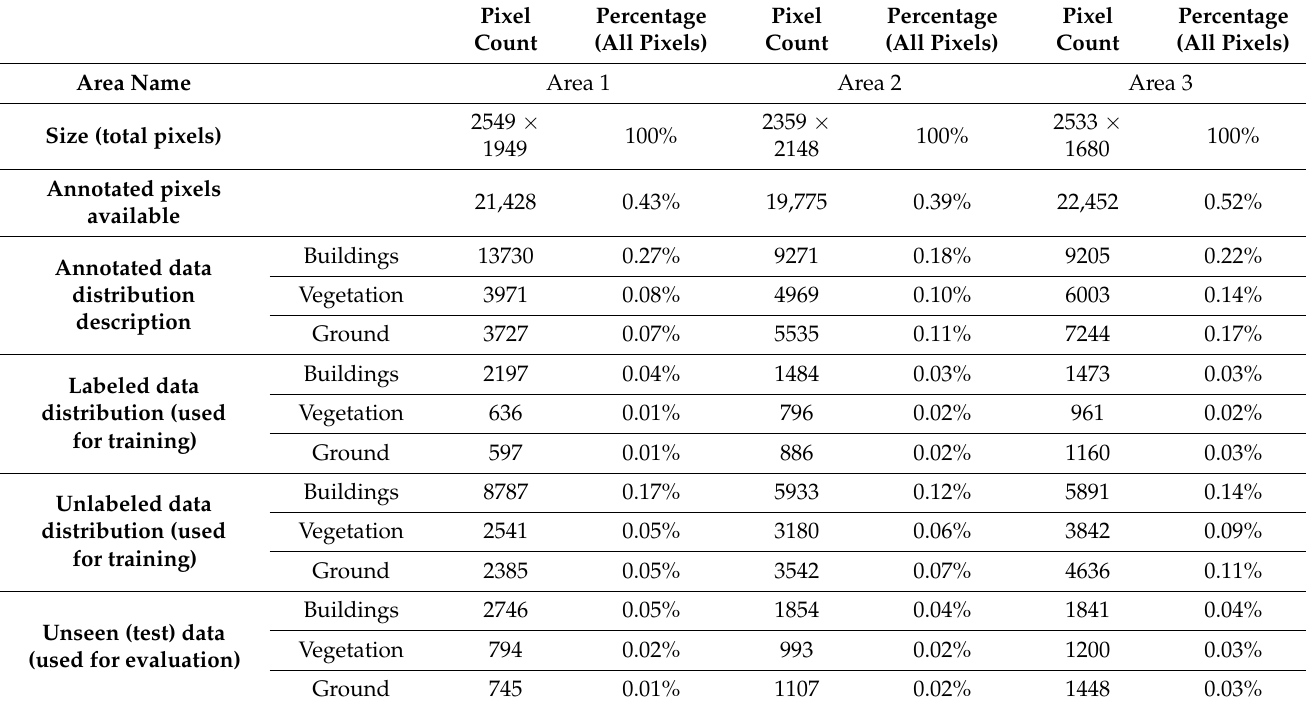
Table 2. Demonstrating the data distribution, utilized for the training and testing processes.